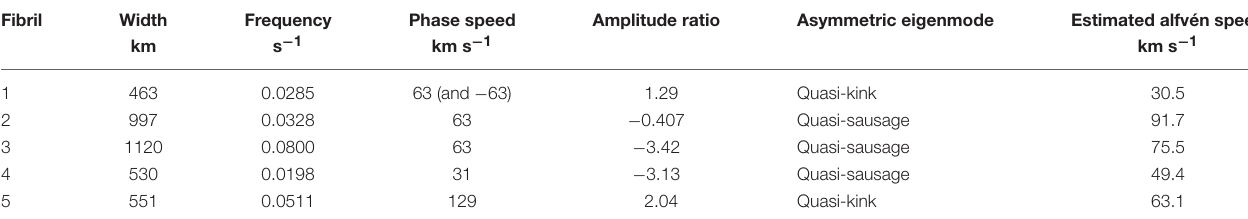
TABLE 2 | A table of measured parameters, identified mode, and estimated local Alfvén speed of five chromospheric fibrils. Fibril Width Amplitude